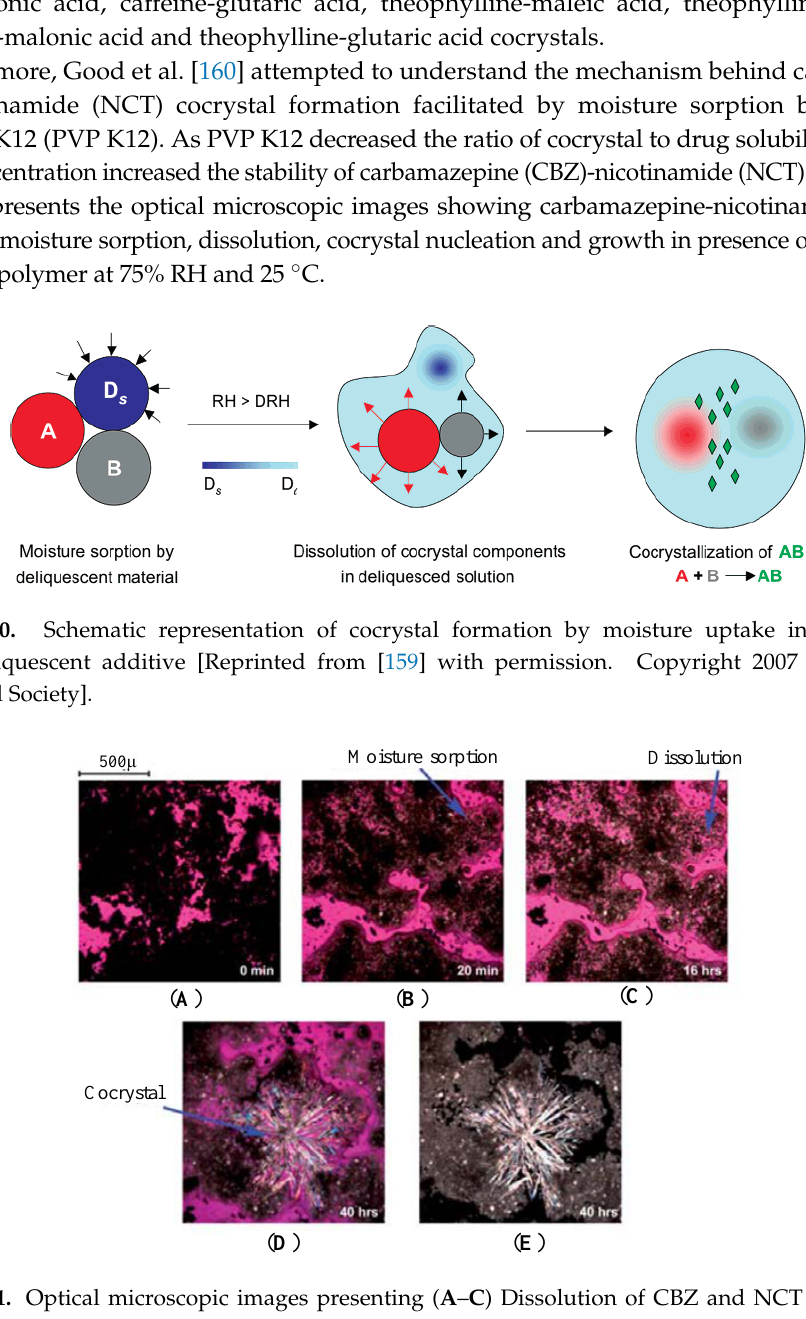
Figure 11. Optical microscopic images presenting (A-C) Dissolution of CBZ and NCT and (D-E) CBZ-NCT cocrystal formation by moisture sorption by PVP K12 in equimolar concentration of CBZ and NCT at 75% RH and 25 °C [Reprinted from [160] with permission. Copyright 2011 Royal Society of Chemistry].